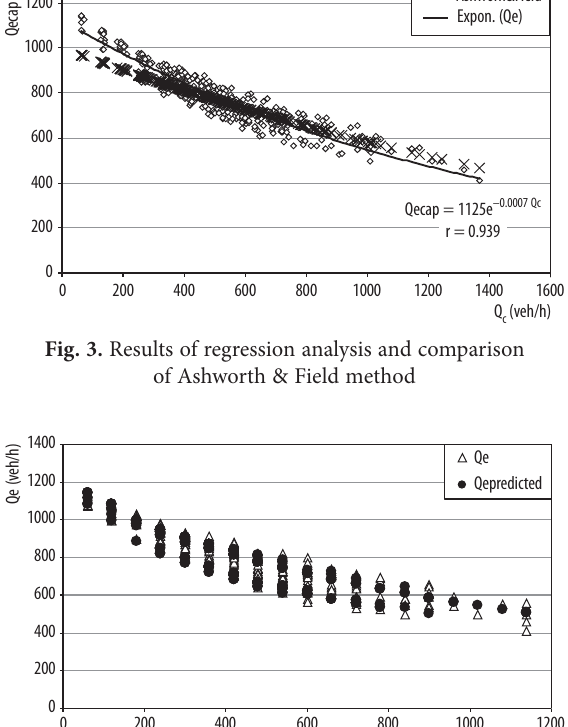
Fig. 4. Th e plot of the observed and predicted capacity values of the critical gap acceptance